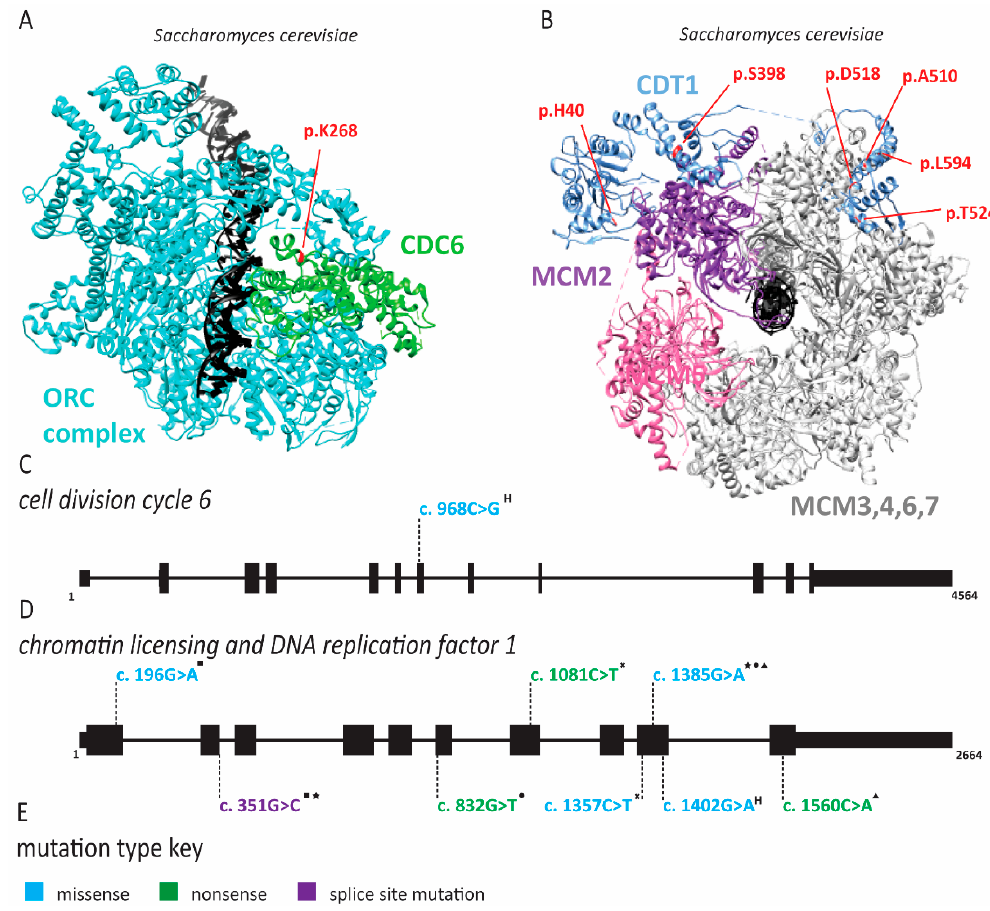
Figure 3. Mutations in chromatin licensing and DNA replication factor 1 ( CDT1 ) and cell division cycle 6 ( CDC6 ) cause Meier-Gorlin syndrome. Pathogenic mutations of CDC6 and CDT1 are depicted on a schematic of each gene and crystal structure of Saccharomyces cerevisiae proteins. Mutations that do not have corresponding amino acids in the structure or resulted in abnormal splicing are not depicted. For a complete list of mutations and associated protein changes, see Supplementary Table S1. Alignment of Homo sapiens and Saccharomyces cerevisiae genes was completed using UniProt alignment tool (https://www.uniprot.org/align/). The structure was generated using pdb file 5v8f and the Chimera program (http://www.cgl.ucsf.edu/chimera). Exon and intron schematics were generated with the UCSD genome browser. Reference sequences are CDC6 NM_001254.4 and CDT1 NM_030928.4. ( A ). Crystal structure of yeast CDC6-ORC-MCM2-7-CDT1 complex (MCM2-7 and CDT1 not shown) with the amino acid associated with missense mutation p.T323R (c.968C > G) is depicted. ( B ) Crystal structure of yeast CDC6-ORC-MCM2-7-CDT1 complex (CDC6 and ORC not shown) with amino acids corresponding to missense and nonsense mutations in the human protein identified in red on the crystal structure of yeast CDT1. Schematic of ( C ) CDC6 and ( D ) CDT1 genes depicted with exons as black boxes and introns as horizontal lines. Mutations are mapped to the appropriate gene regions. “H” superscript indicates a homozygous mutation. Compound heterozygous mutation pairs are indicated by superscript symbols. Each mutation combination is depicted, and certain alleles may be present in multiple combinations. The frequency of each allele in the affected population is not indicated. ( E ) For each gene, the color of the mutations indicates the type of mutation according to this key.